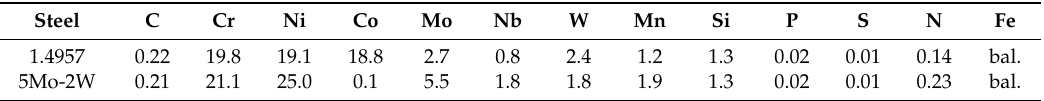
Table 1. Chemical composition of the investigated steels 1.4957 and 5Mo-2W (in wt.%) measured via